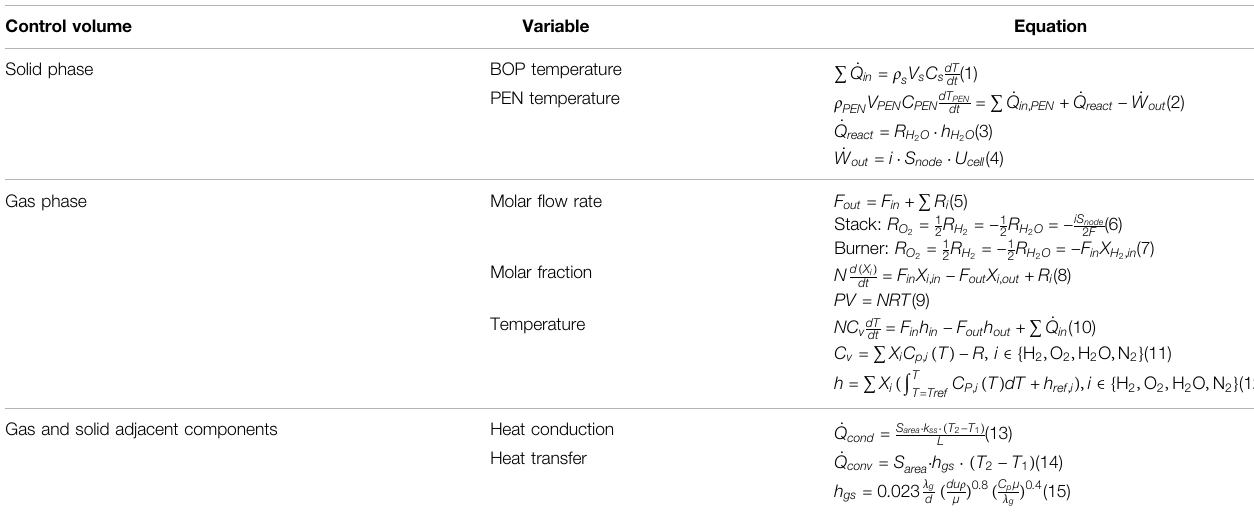
TABLE 2 | Universal SOFC system building